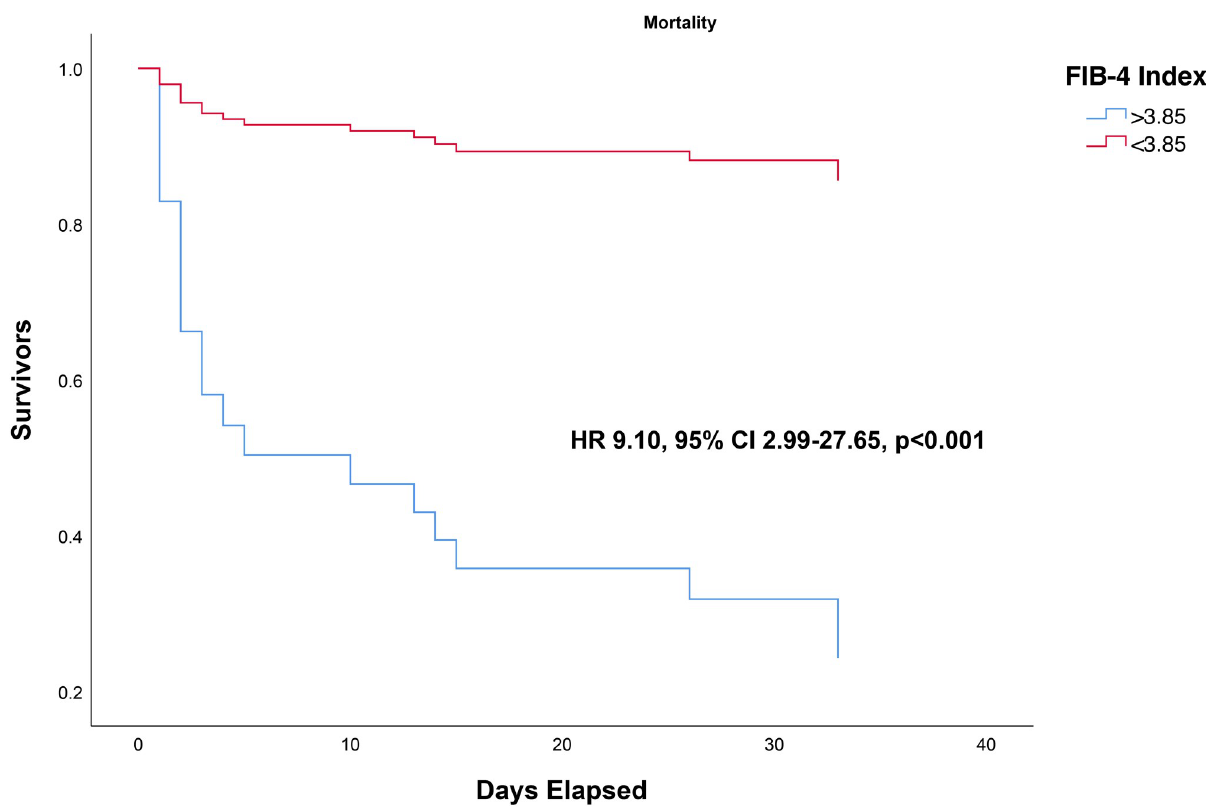
Fig 3. Time-to-event analysis for FIB-4 > 3.85 and mortality (3-months survival). All of the events occurred at or before the 34 th day.